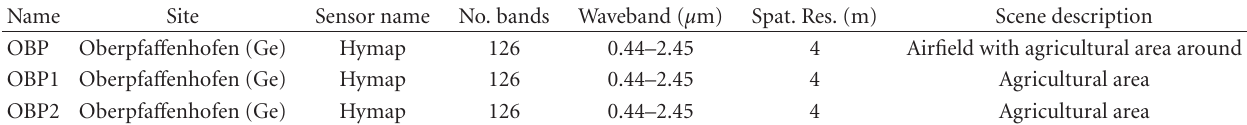
Table 1: Datasets information—OBP1 and OBP2 are parts of OBP.